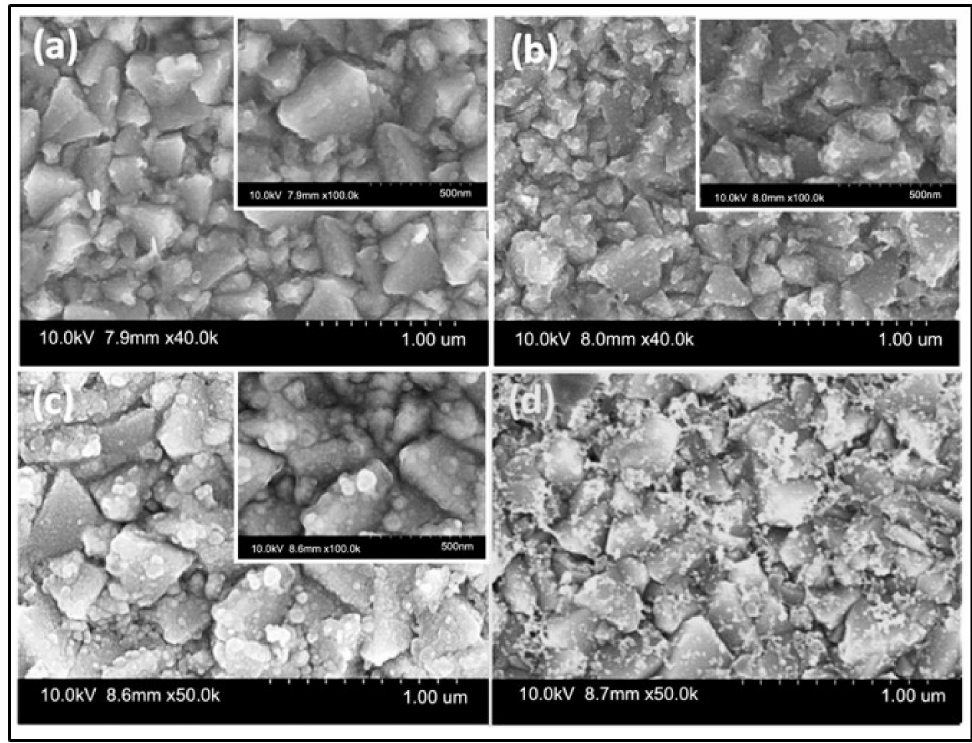
Figure 10. FESEM snaps of ( a – c ) FTO/MCS (3, 6, and 9 cycles) and ( d ) FTO/Pt CEs. Adapted with permission from reference [129]. Copyright 2022, IOP